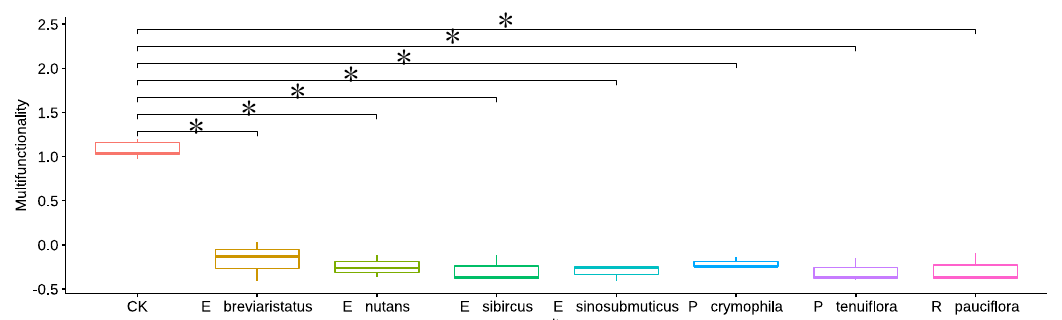
Figure 1. Soil EMF at natural and artificial grasslands: Effects of artificial grasslands. CK: Natural temperate steppe. E breviaristatus: Elymus breviaristatus . E nutants: Elymus nutans . E sibircus: Elymus sibircus . E sinosubmuticus: Elymus sinosubmuticus . P crymophila: Poa crymophila . P tenuiflora: Puccinellia tenuiflora . R pauciflora: Roegneria pauciflora . *: p ＜ 0.05.